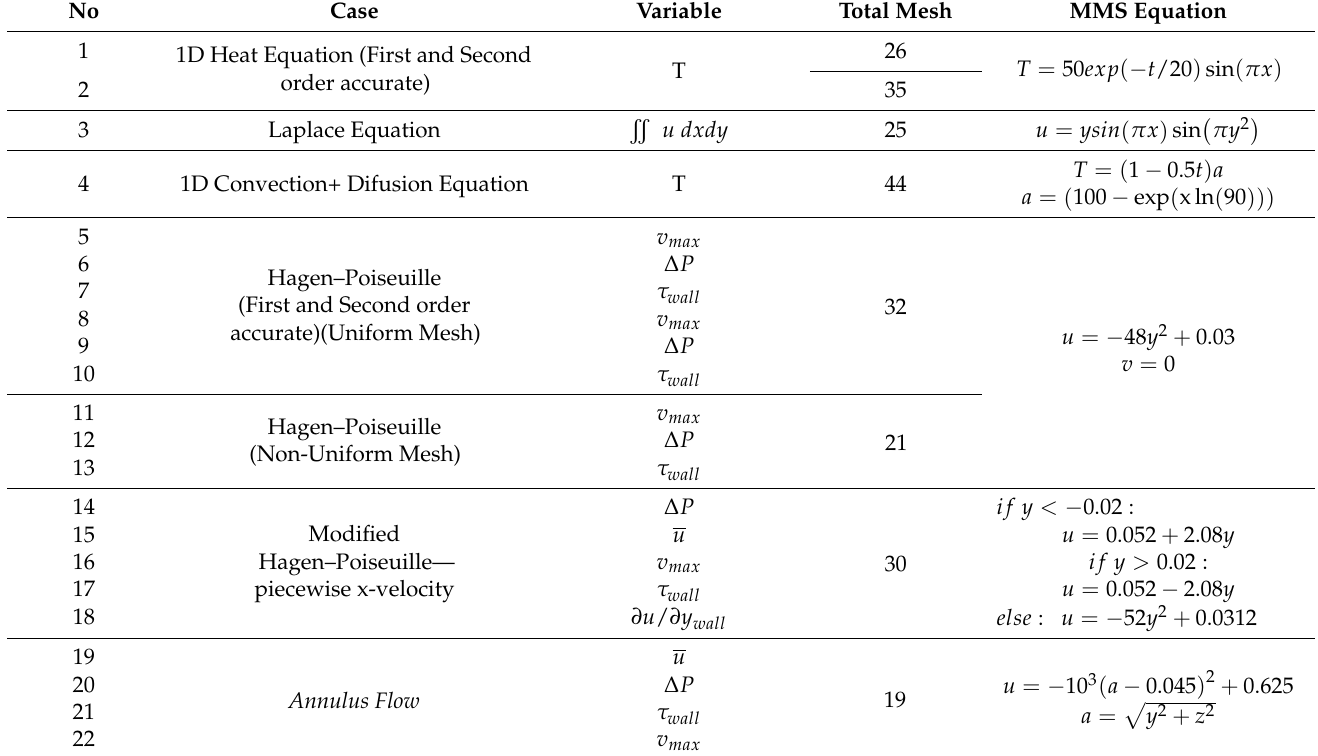
Table 1. Details of the method of manufactured solution (MMS)